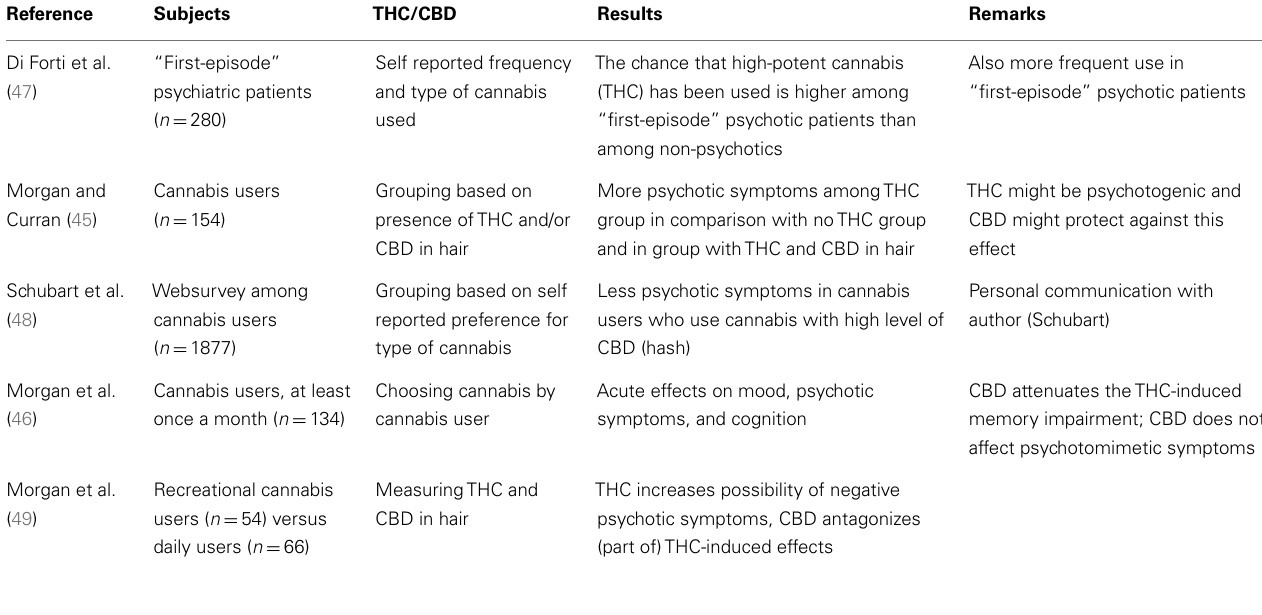
Table 1 | Summary of “naturalistic” studies in which the effects of cannabidiol and cannabis with a high dosis ofTHC on psychological functions have been